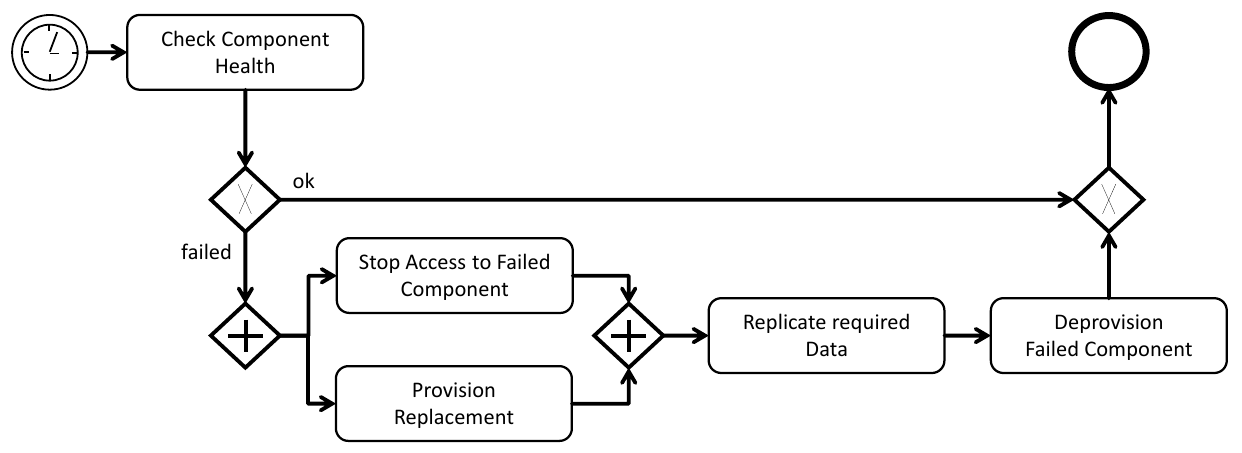
Figure 10. Abstract Management Flow of the Resiliency Management